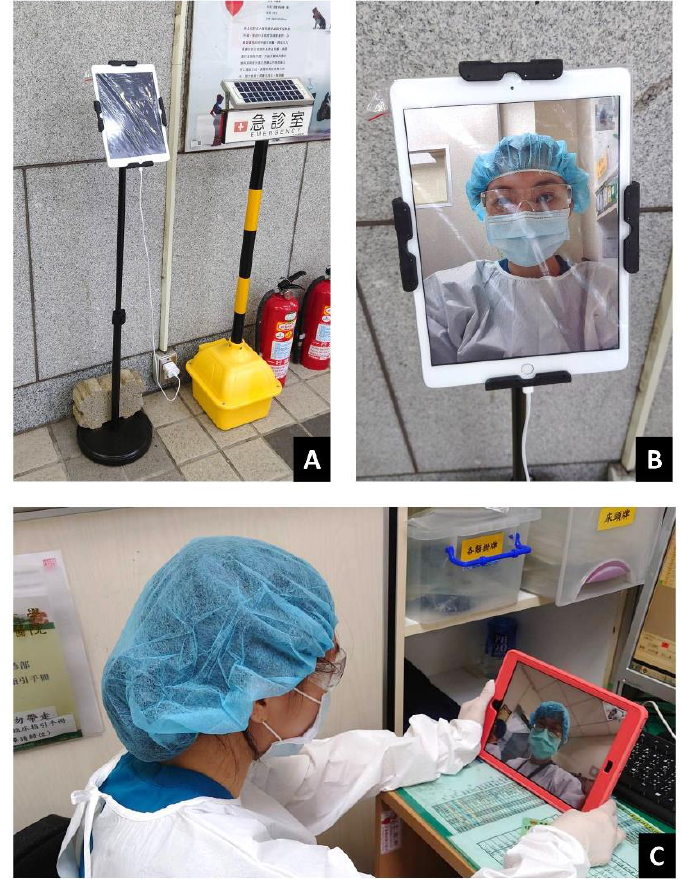
Figure 3. iPad in the quarantine zone. ( A ). The iPad in the quarantine zone was placed on an immo- bile security stand and covered with a transparent plastic wrap, which was regularly changed, and the tablet was sanitized after each encounter. ( B ). This picture shows the patient’s view of the tablet in the quarantine zone when a physician initiated virtual communication via FaceTime. ( C ). Virtual communication between physicians in different zones could be achieved with iPads and FaceTime. The photo consent was obtained.